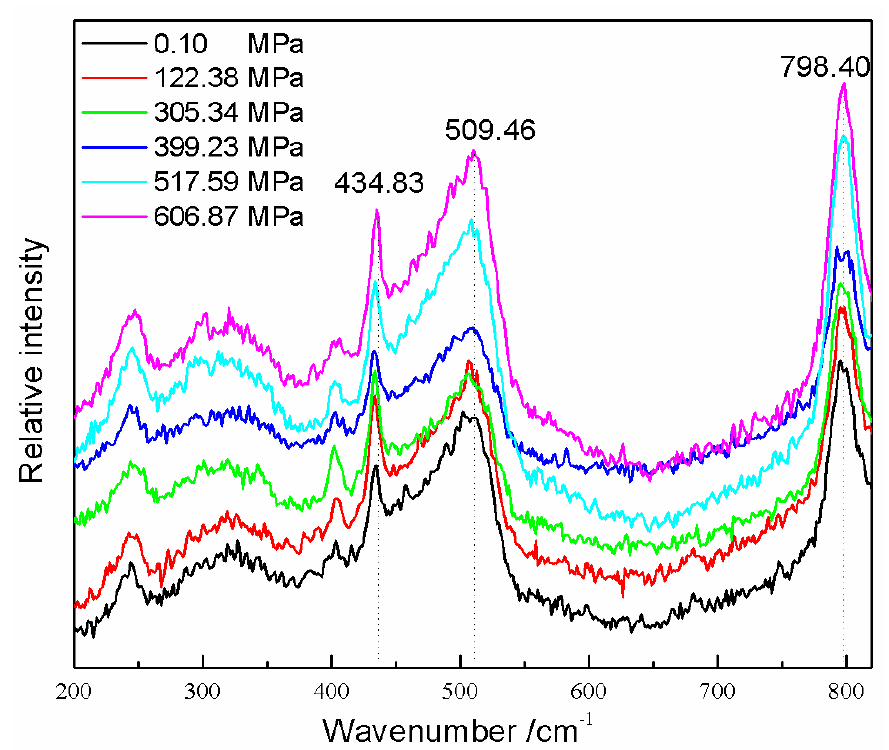
Figure 2. Raman spectra of colorless orthoclase at different pressures. The labelled numbers refer to the peak position at around 600 MPa pressure. The spectra are stacked for comparison. Table 2. Raman spectra data of colorless orthoclase at different pressures.